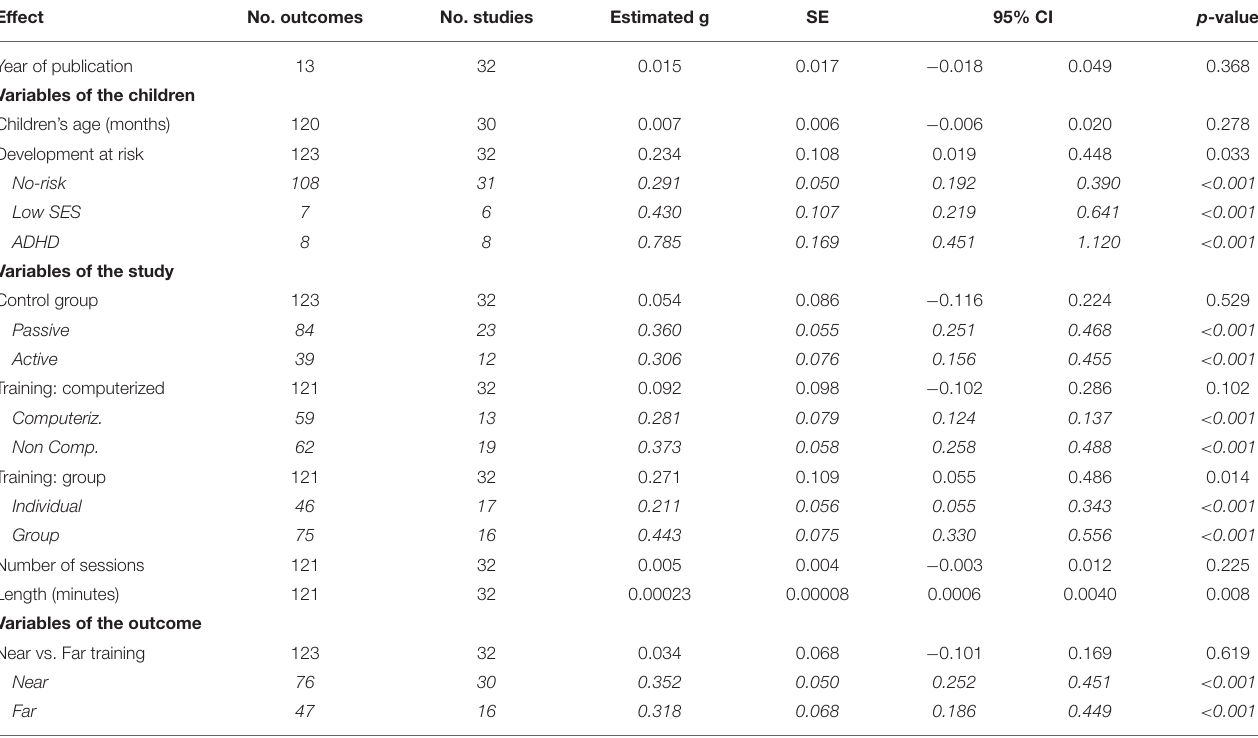
TABLE 3 | Moderation effects for the primary outcomes of the meta-analysis.